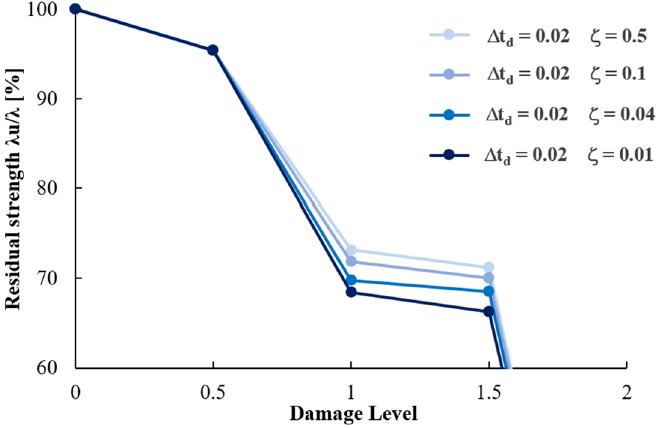
Figure A8. Robustness curves for 2D RC frame structure for location 2: effect of variation of damping ratio. Δ t d values are expressed in seconds.